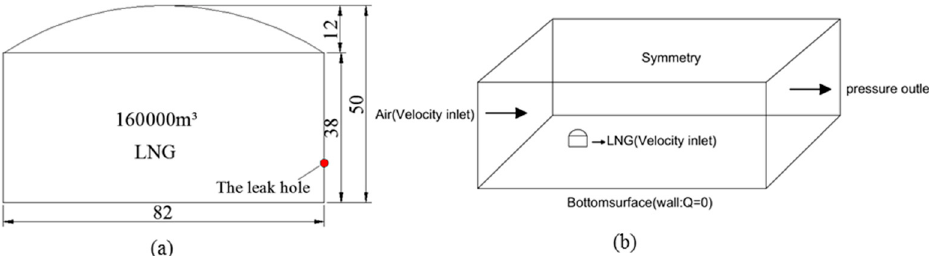
Figure 1. The settings of the large-scale LNG storage tank. ( a ) Geometric schematic of the tank; ( b ) the boundary settings of the tank.